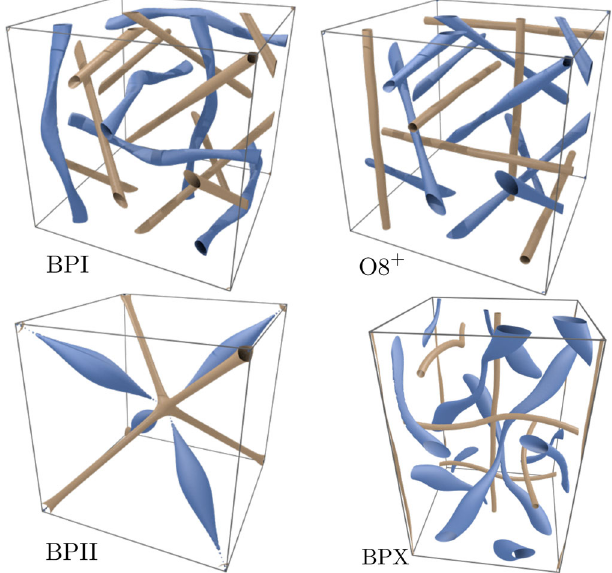
FIG. 5. Umbilic lines in the blue phases. The umbilics are indicated by blue isosurfaces, while the network of disclination lines is shown by milk chocolate isosurfaces. The textures BPI and BPII are the cubic structures observed experimentally. O 8 þ is a cubic structure with the same space group as BPI but an interchange between disclination lines and umbilics. BPX is a tetragonal texture observed in an applied electric field. The arrangement of disclinations and umbilics is the same as in O 8 þ , although the symmetry is